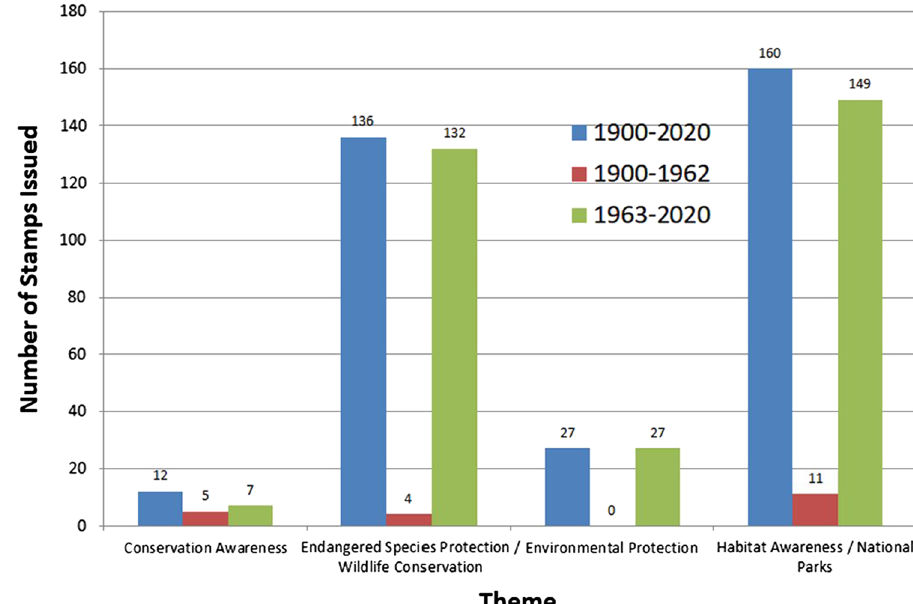
Fig. 1 Number of stamps per four organizational themes before/after 1962, indicating effect on depiction of con- servation and environmental causes related to publication of Silent